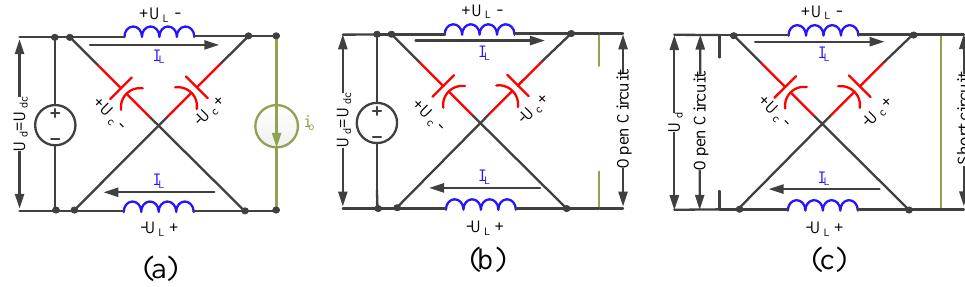
Figure 2. Z-source network in the mode of ( a ) dynamic non-shoot-through; ( b ) inactive non-shoot-through; and ( c ) shoot-through states.